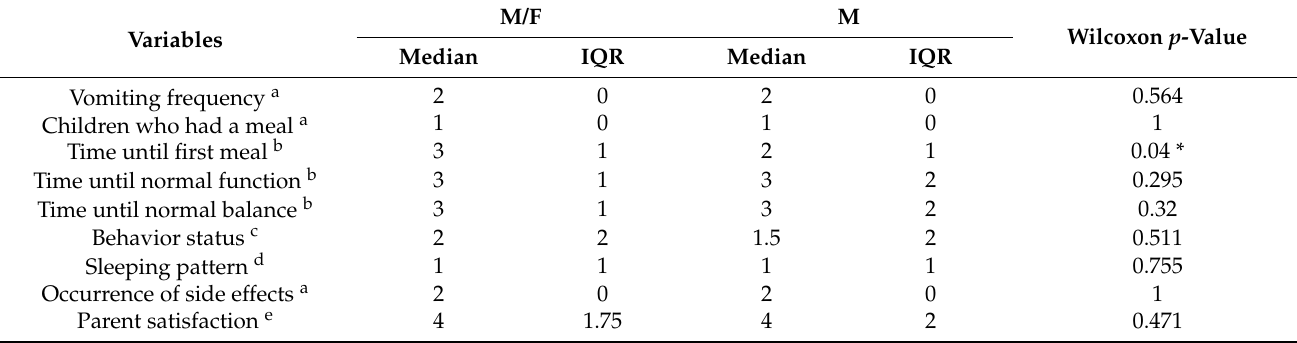
Table 2. The different post-discharge adverse effects of the two sedation groups.